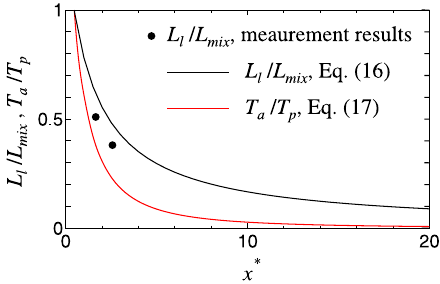
Fig. 13 Estimation of the mixing length ratio L l / L mix and the mixing time ratio T a / T p